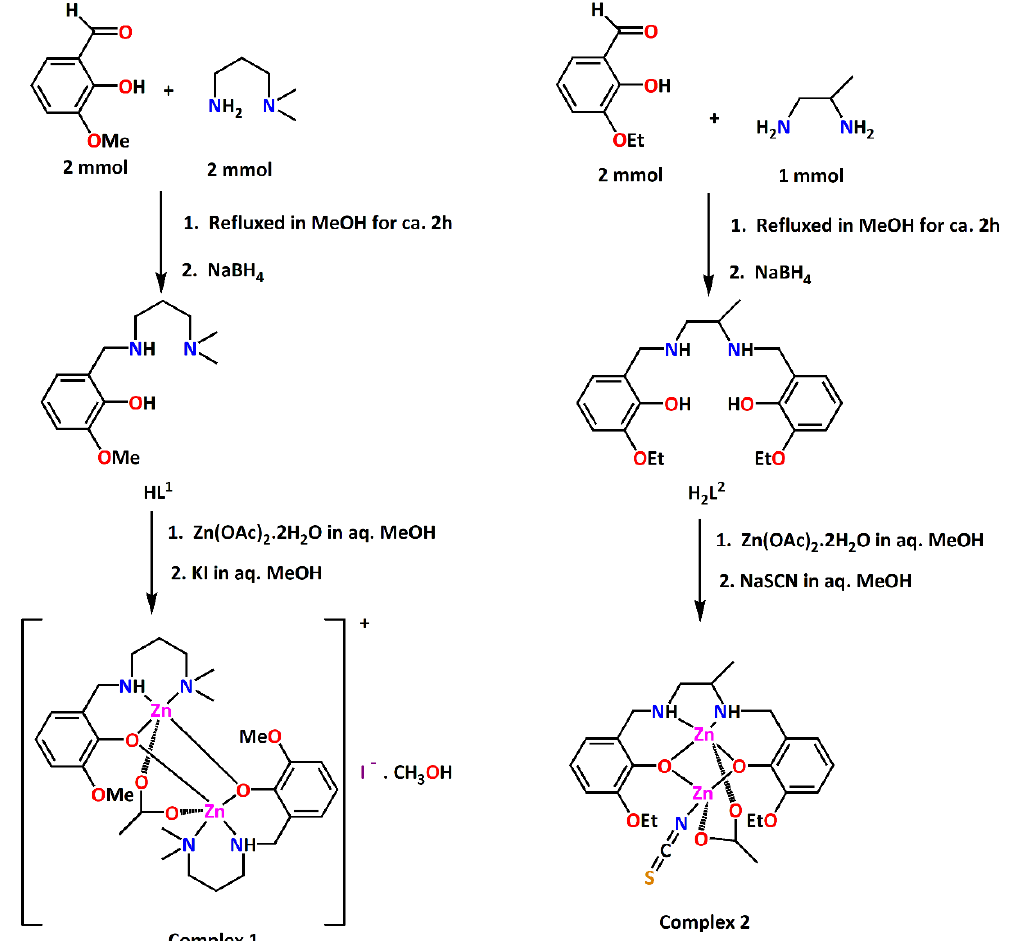
Figure 1. Synthetic routes to complexes 1 and 2 .